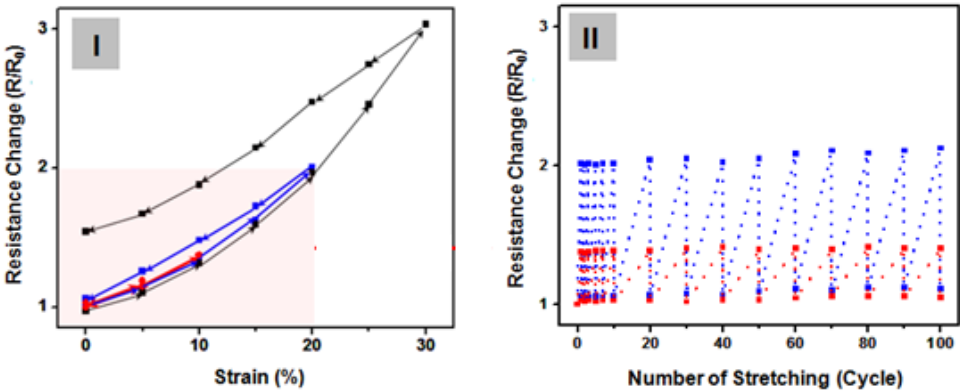
Figure 5. ( I ) Hysteresis curve of the film comprising a Ag NW-network-embedded PDMS film (at tensile strains ( ε ) of 10%, 20%, and 30%). ( II ) Effect of repeated stretching on the resistance change (R/R 0 ) at strain recovery (stretch/release cycles of ε = 10% and